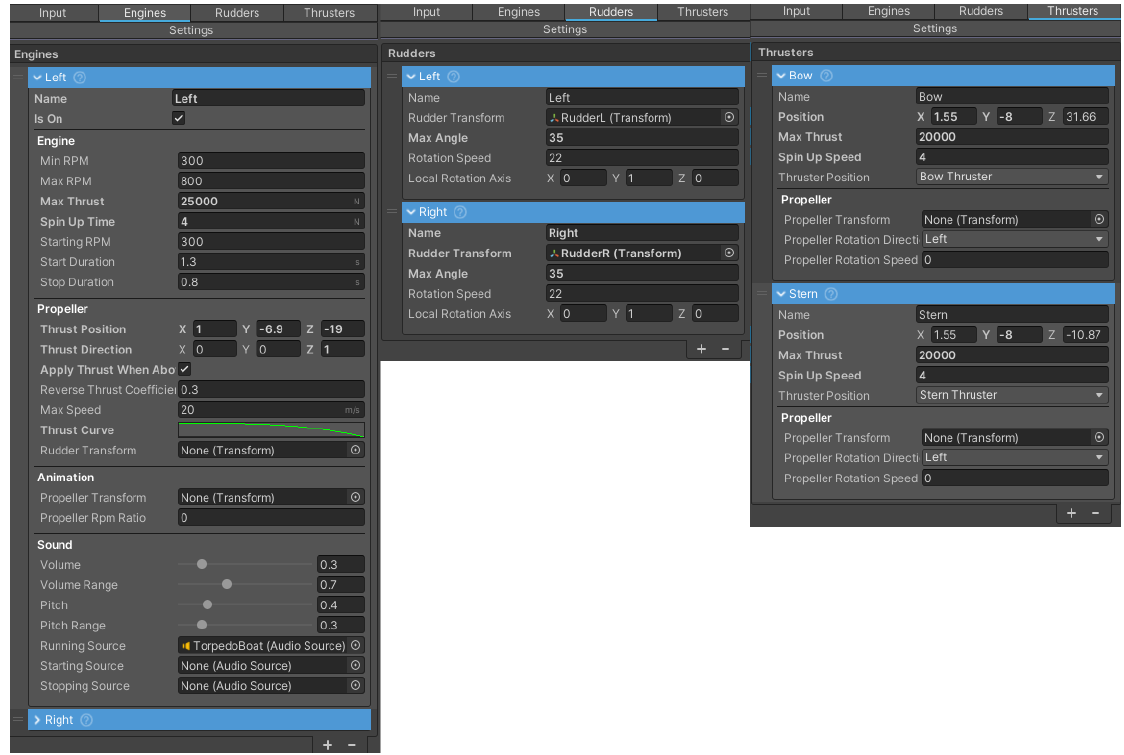
Figure 18. Tabs of the “ Advanced Ship Controller ” component.